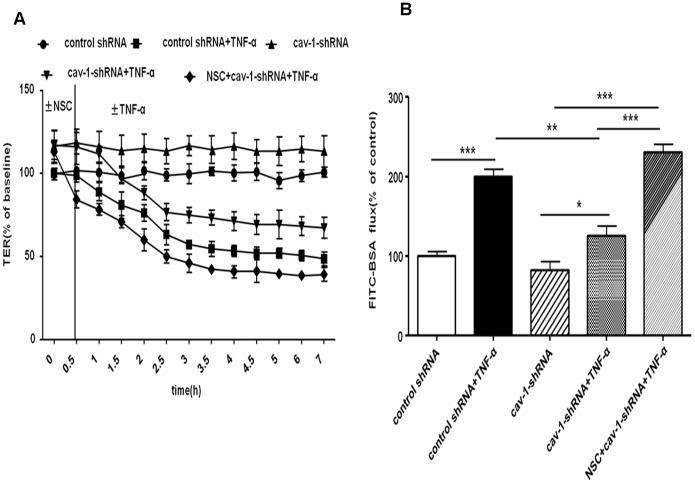
Effect of down-regulation of caveolin-1 on TNF-α-induced hyperpermeability of PMVEC monolayer.A: Effect on TER of PMVEC monolayer. Compared with control shRNA group, the mean baseline TER of PMVECs monolayer increased by 116±10% in Cav1-shRNA group. When challenged with TNF-α, TER of PMVECs monolayer decreased conspicuously in control shRNA more than in Cav-1-shRNA group. Compared with control shRNA cells at different time, prêtreatment with NSC-23766(30 min) significantly abolished the increasing TER in Cav-1-deficient cells monolayer with or without TNF-α stimulation. B: Effect on flux of BSA across PMVEC monolayer. The Flux of FITC-BSA in Cav-1-deficient cells monolayer decreased mildly. Treatment with TNF-α for 2 h significantly increased the flux of BSA in control shRNA group more than in cav-1-shRNA group. Moreover, co-treatment with NSC-23766 and TNF-α, the Flux of FITC-BSA of Cav-1-deficient PMVECs monolayer was increased more severely than that without application of NSC-23766. *P<0.05, **P<0.01, ***P<0.001.